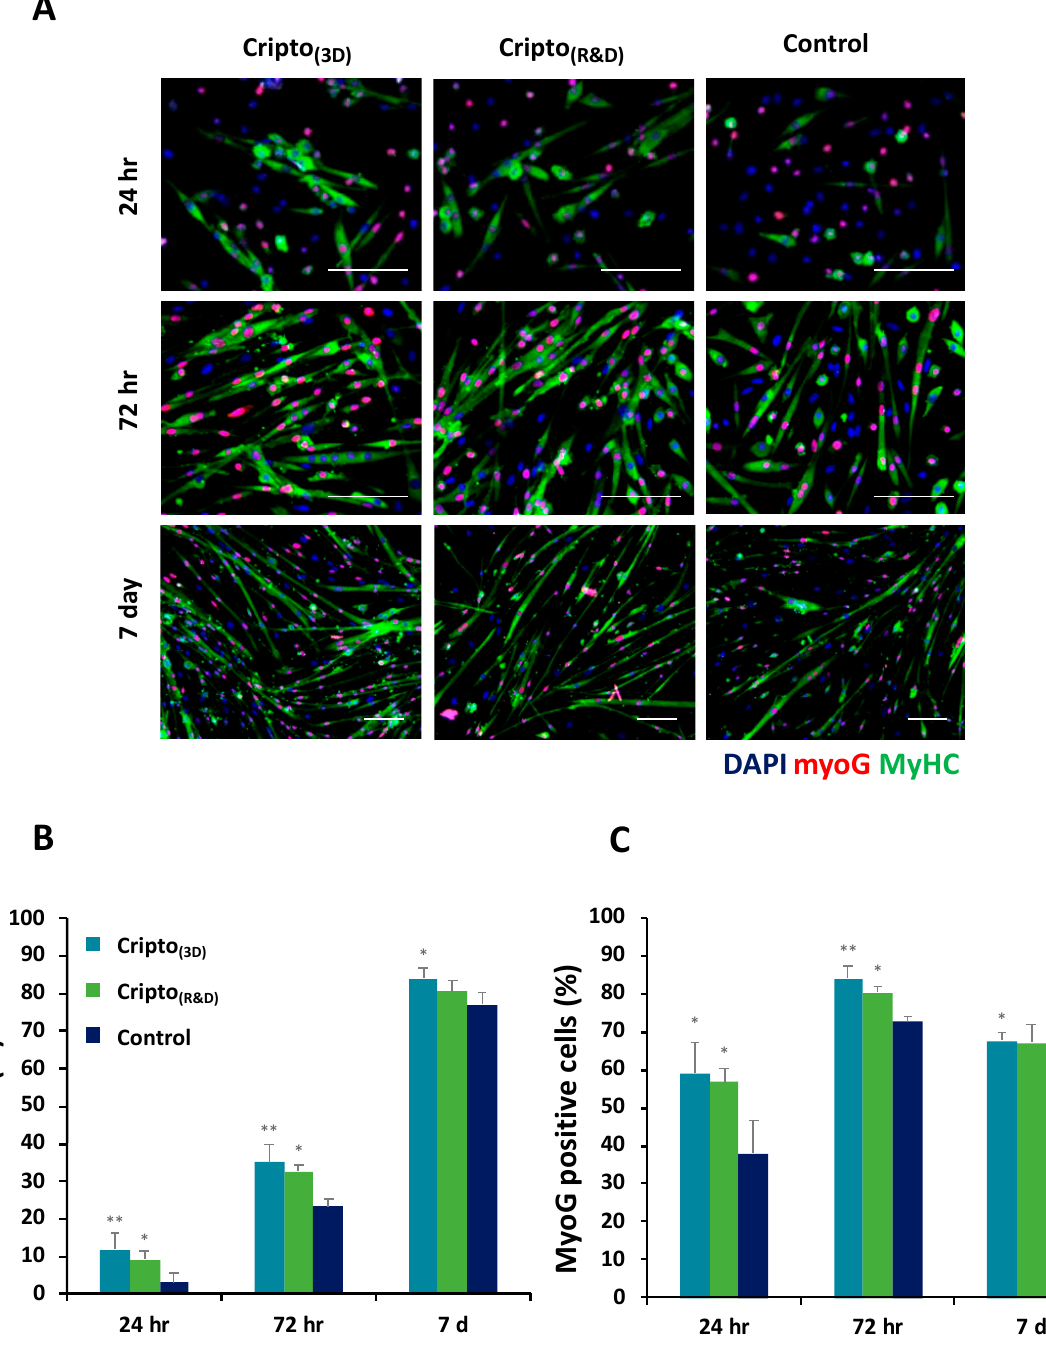
Figure 6. Cripto protein produced in 3D microcarriers retains the ability to induce muscle satellite cell commitment toward a differentiative fate. Muscle satellite cells were cultured in 10% HS medium containing Cripto (3D) or commercial Cripto (R&D) and compared to the control group (containing only 10%FBS medium). ( A ) Cells were stained with DAPI (blue), MyHC (green), and myoG (red), and representative images were obtained for 24 h, 72 h, and 7 days in culture. ( B ) Differentiation was estimated by measuring the fusion index, which is the percentage of nuclei within MyHC-positive cells. ( C ) Quantification of MyoG-positive nuclei per total myonuclei, as identified with a DAPI counterstain. Results are shown as mean ± S.D. of at least three independent experiments. * indicates p < 0.05, ** indicates p <